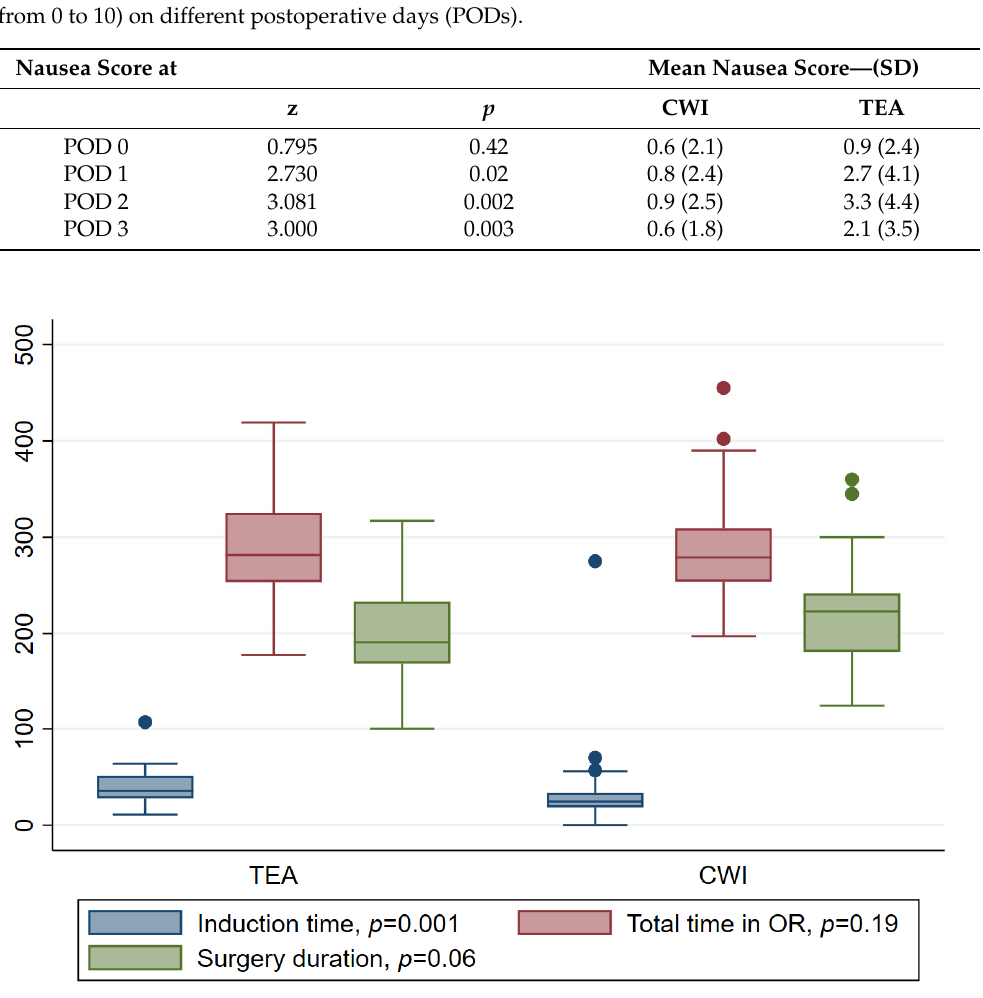
Figure 1. Visual comparison in surgical procedure between patients managed with thoracic epidural analgesia (TEA) and continuous wound infiltration (CWI) expressed in minutes. Total time in the operating room (OR) is the patient’s entire stay in OR. Induction time starts with the first administration of anesthesia drugs. Surgery duration is calculated from skin incision till skin closure. Table 1. Patients’ characteristics of the two studied populations either with continuous wound in- fi ltration (CWI) or with thoracic epidural analgesia (TEA).